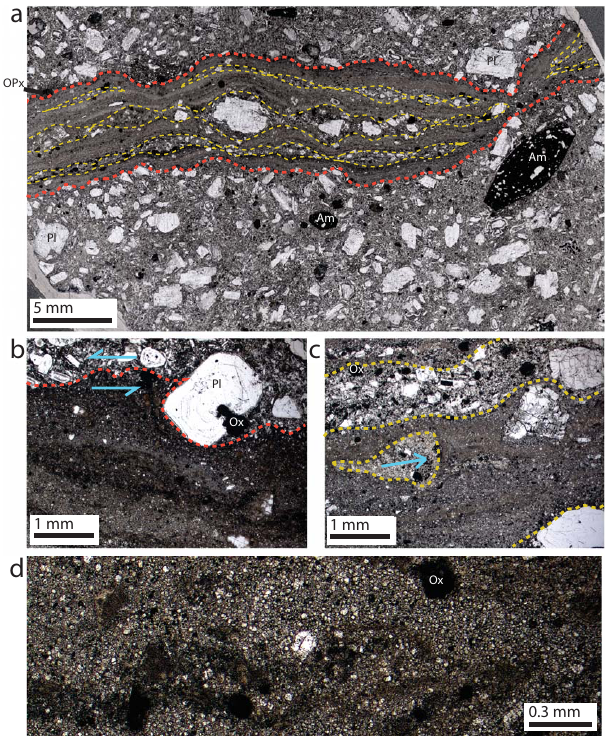
Fig. 2. Photomicrographs of the shear band. (a) , a wide view of pseudotachylyte (dark grey) and cataclasite (grey) layers in the shear band cutting through the andesite host rock, containing pla- gioclase (Pl), amphibole pseudomorphs (Am, replaced by reaction products), pyroxene (here OPx) and FeTi oxides (Ox). Morphology of the vein shows the shear band pinching out and lenses of cata- clasites between pseudotachylyte veins of more constant thickness, which show flow textures. (b) , inferred shear direction from flow morphology of the pseudotachylyte around a host-rock phenocryst at the vein boundary. (c) , cataclastic lens hosted in a pseudotachy- lyte layer with bulbous onset and elongate tail indicating flow di- rection of the band. (d) , internal structure in the pseudotachylyte– cataclasite interface indicating turbulent flow. Red dashed lines mark the boundary of the shear band, yellow dashed lines show boundaries between pseudotachylyte and cataclasites, arrows rep- resent inferred flow/shear